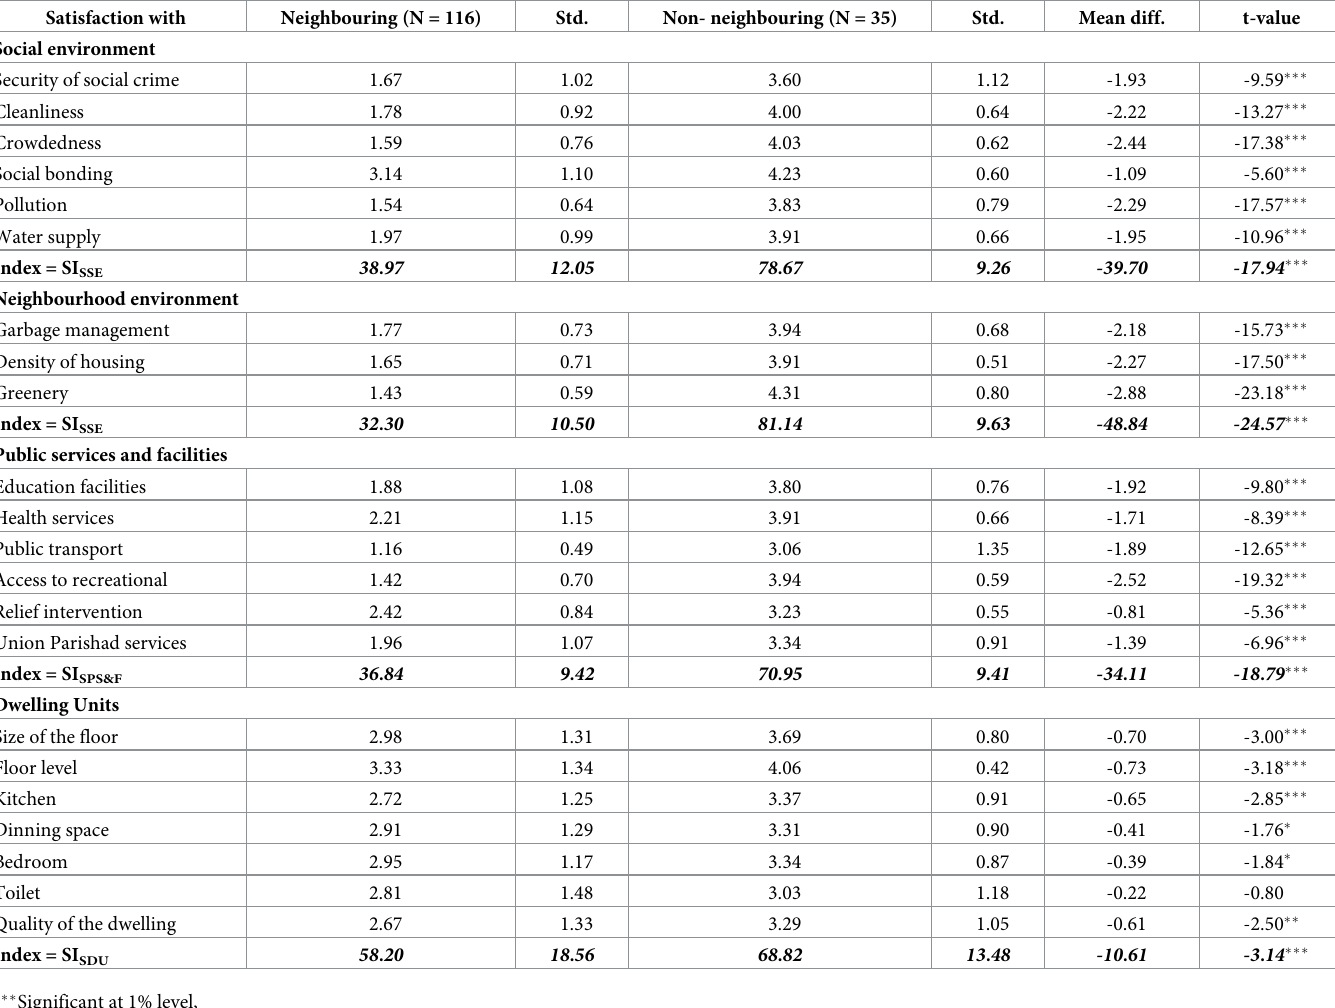
Table 5. Mean difference of residential satisfaction issues between neighbouring and non- neighbouring. Satisfaction